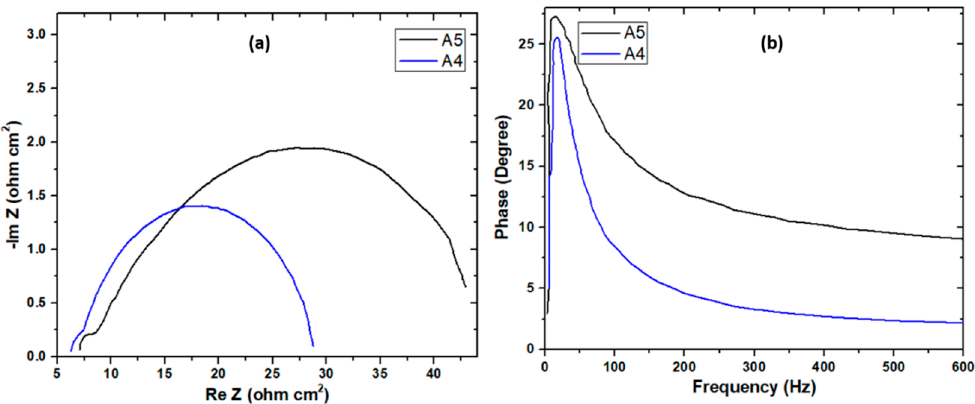
Figure 1. EIS measurements. ( a ) Nyquist plot. ( b ) Bode plot, adapted from reference [70]. Singh et al. explored why orange Nasturtium flowers considerably enhance electron lifetimes (588 µs) compared with the yellow ones (459 µs) [68]. The latter can be attributed to the low Rec resistance of the orange dye that retrains the recombination of electrons and iodine species.